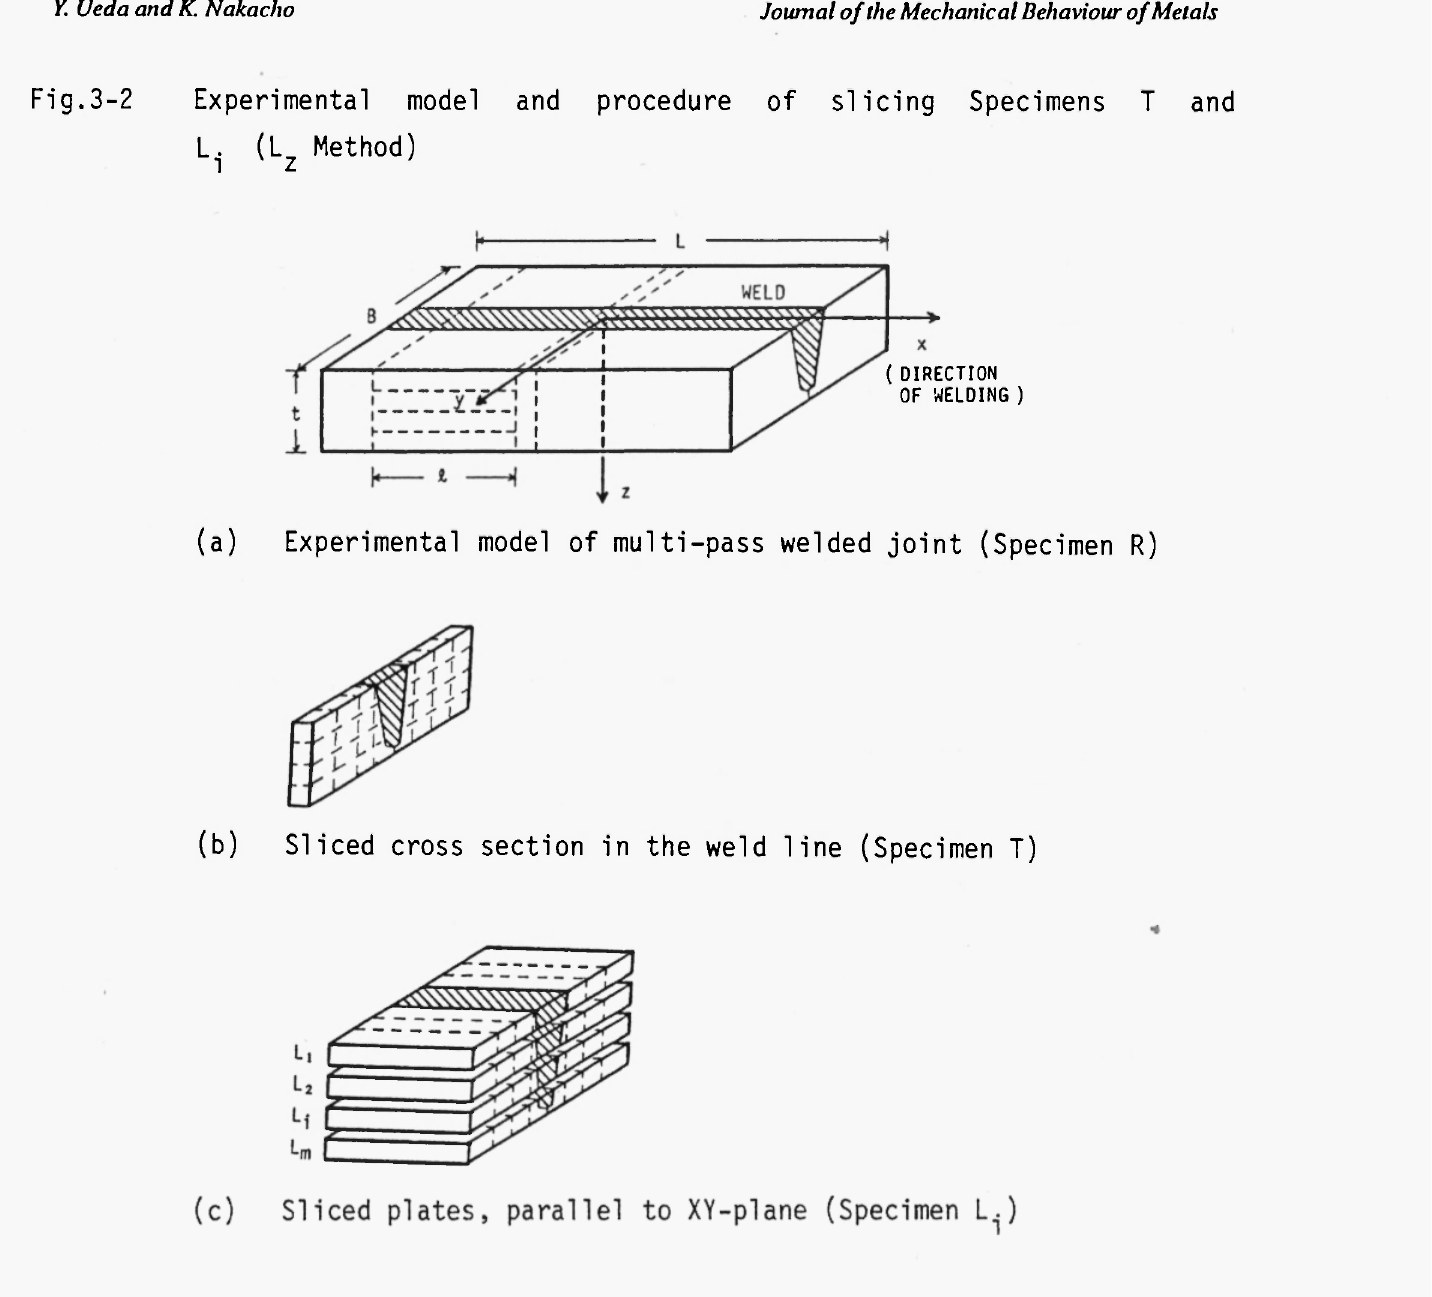
Fig.3-2 Experimental model and procedure of slicing Specimens Τ and